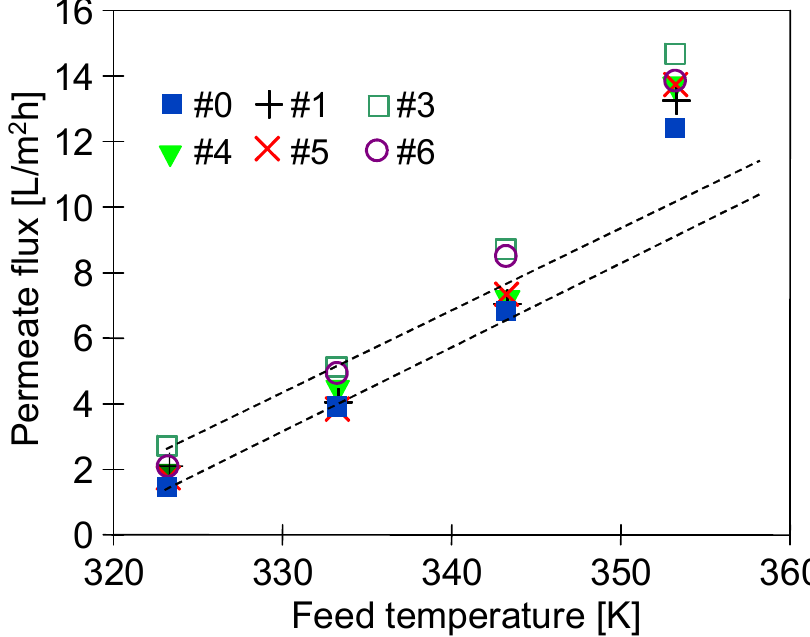
Figure 16. Impact of the feed temperature on the permeate flux. Feed: NaCl solution (3 g/L). Five years after plasma treatment.